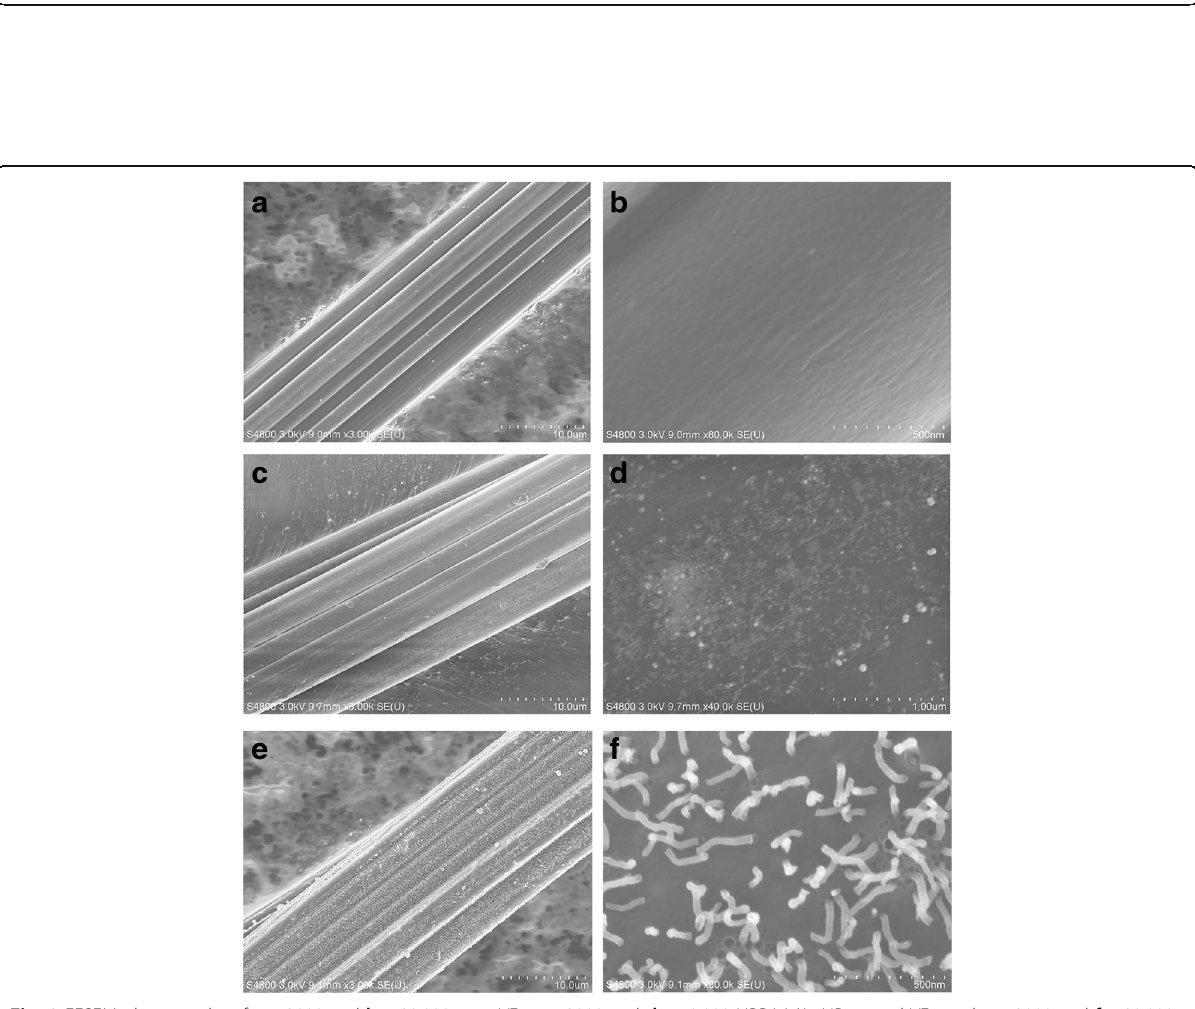
Fig. 1 Preparation process of ACFs with dense Ag nanohair through self-assembly and thermal expansion and contraction mechanisms